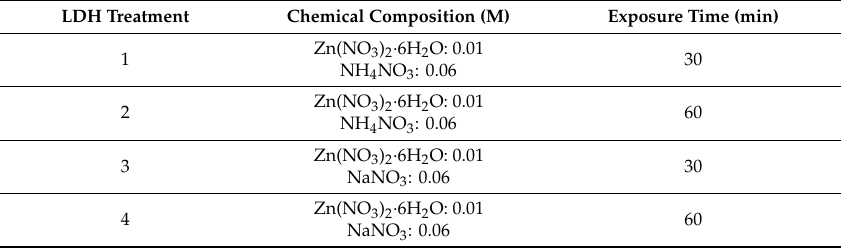
Table 2. LDH synthesis conditions of